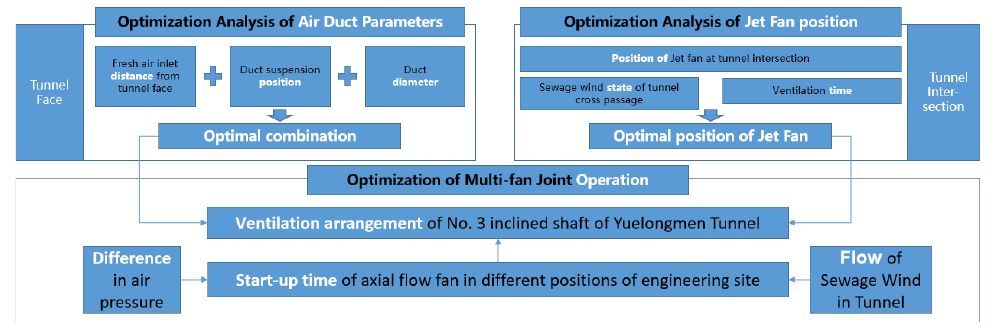
Figure 1. Schematic representation.